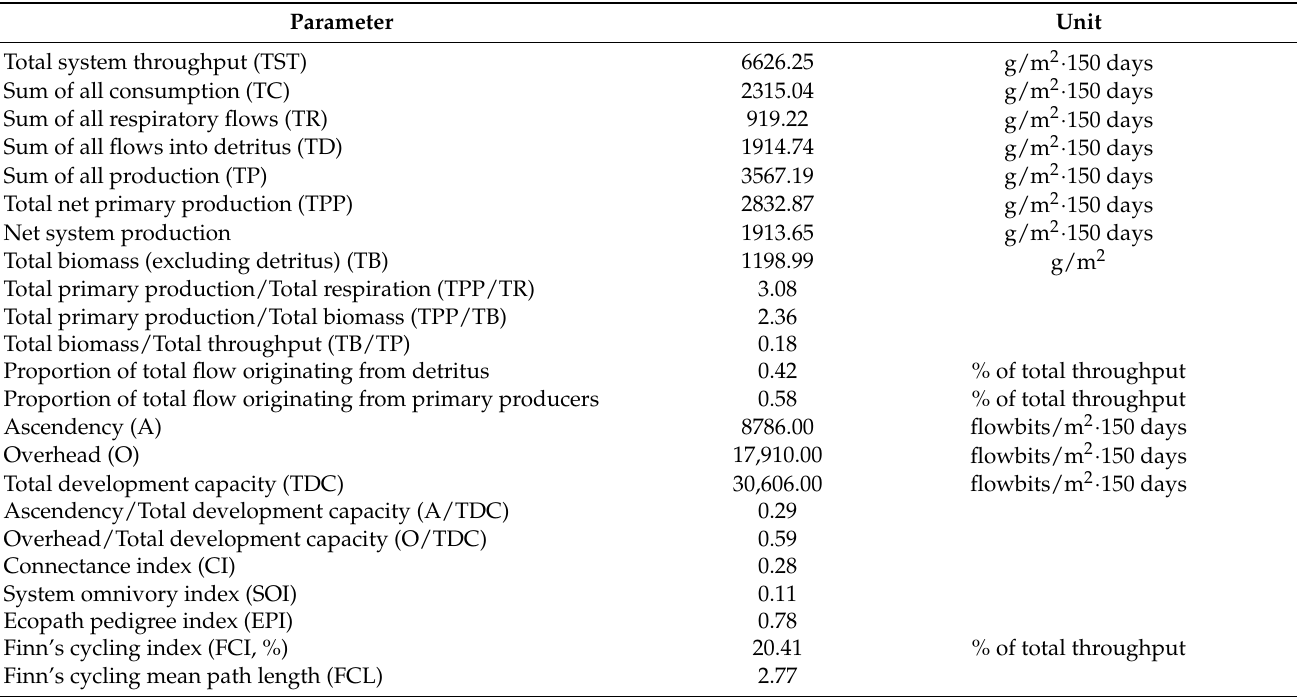
Table 3. Systematic characteristics.